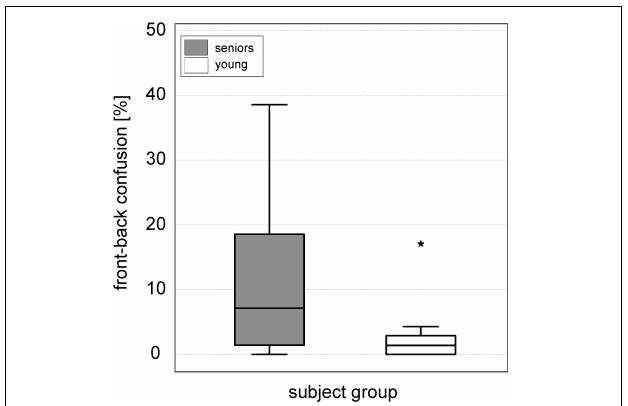
FIGURE 6 | Boxplots of front-back confusions [%] in the sound localization test for the senior study participants (gray box) compared to a reference group of nine young adults with normal hearing (white box). * Outliers 3 times greater than interquartile range.